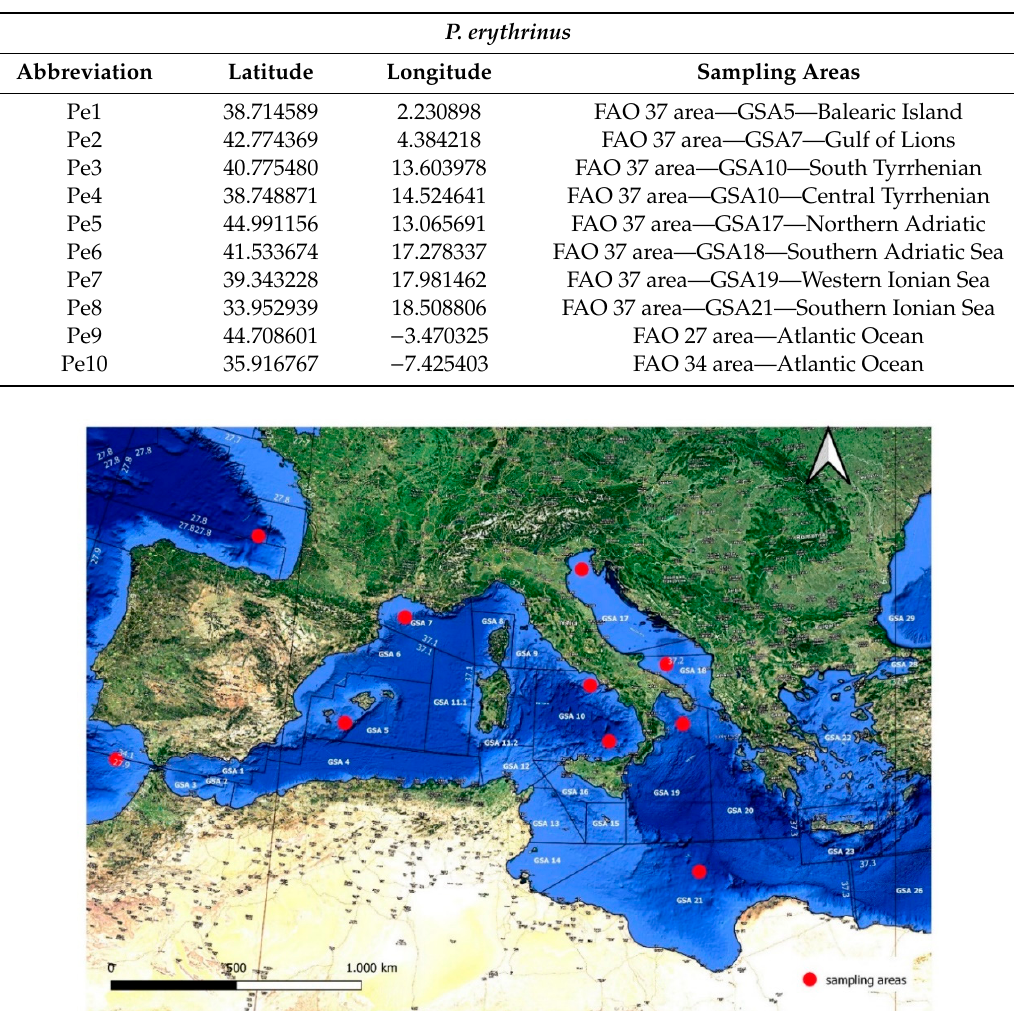
Table 2. Fish species other than P. erythrinus used in this study by end ‐ point PCR and Real ‐ Time qPCR. Common names are from ASFIS List of Species for Fishery Statistics Purposes